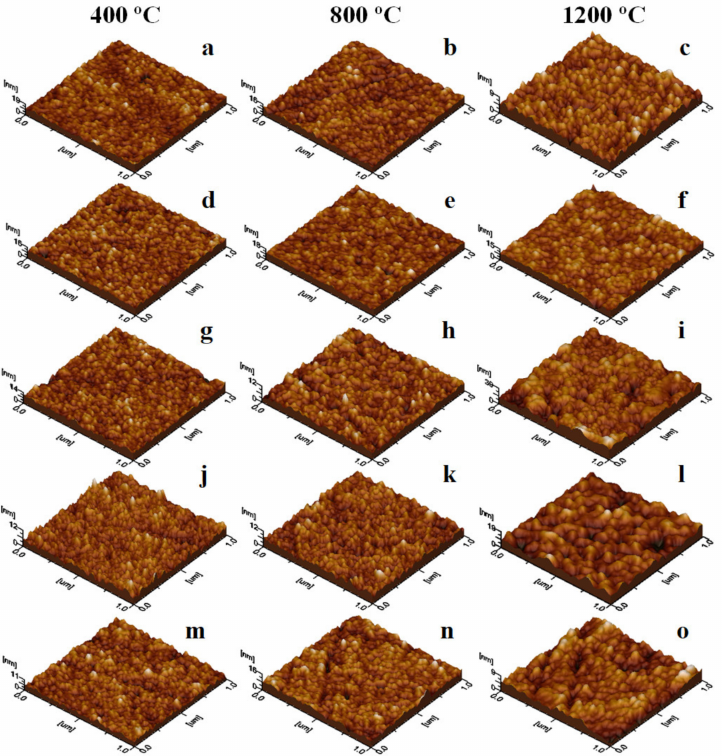
Figure 3. AFM 3D images of Mn 1 − x Ni x Fe 2 O 4 @SiO 2 NCs annealed at 400, 800, and 1200 ◦ C (x = 0 ( a – c ), x = 0.25 ( d – f ), x = 0.50 ( g – i ), x = 0.75 ( j – l ) and x = 1.0 ( m – o